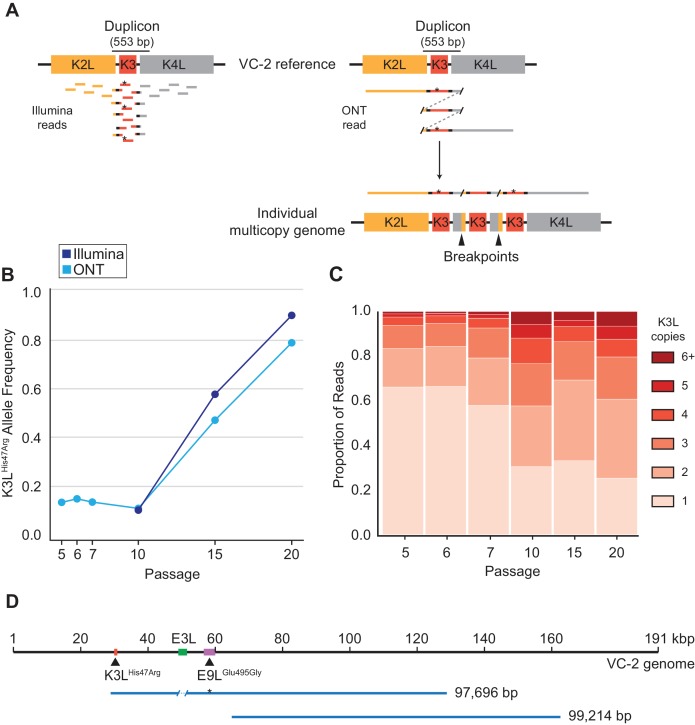
ONT reads capture SNVs and copy number expansions in individual virus genomes.(A) Representative structure of the K3L locus in the VC-2 reference genome is shown on top, with representative Illumina MiSeq and ONT MinION reads shown to scale below. The K3LHis47Arg variant within reads is indicated by an asterisk. ONT reads that split and re-align to the K3L duplicon are indicative of individual multicopy arrays (shown below). Tandem duplication breakpoints flanking the duplicon are indicated by arrowheads. (B) Population-level K3LHis47Arg allele frequency was estimated using Illumina or ONT reads from different passages. E9LGlu495Gly allele frequencies are shown in Figure 2—figure supplement 1. Error rate calculations for different flow cell chemistries are shown in Figure 2—figure supplement 2. (C) For each sequenced passage, K3L copy number was assessed within each ONT read that aligned at least once to the K3L duplicon (see Materials and methods for further details). Detailed plot of reads containing 6 + K3L copies is shown in Figure 2—figure supplement 3. (D) Representative reads from the specific long read preparation are depicted relative to the VC-2 reference genome. The locations of relevant genes are indicated by colored boxes (gene name above or below), and the locations of high frequency variants in K3L and E9L are indicated by arrowheads.10.7554/eLife.35453.018Figure 2—source data 1.Single nucleotide variants in virus populations from Illumina or ONT datasets, used to generate Figure 2B.